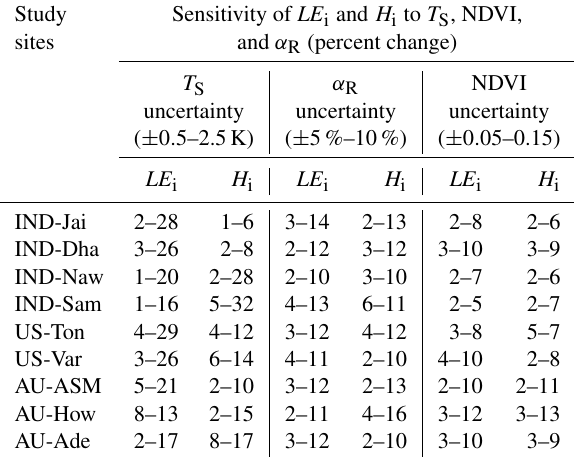
Table 3. Sensitivity (in percent) of LE i and H i due to T S , NDVI, and α R uncertainties.